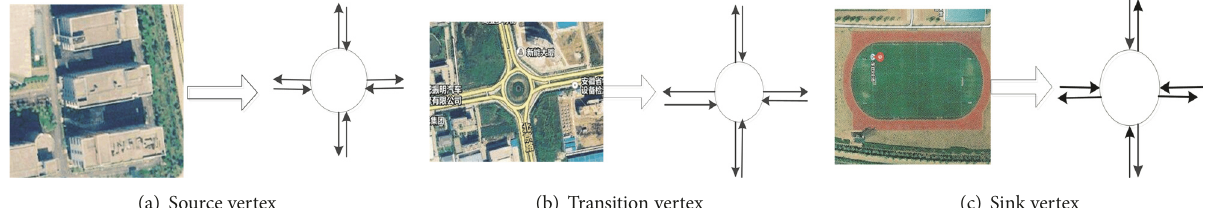
Figure 1: Illustration of the vertices and edges.